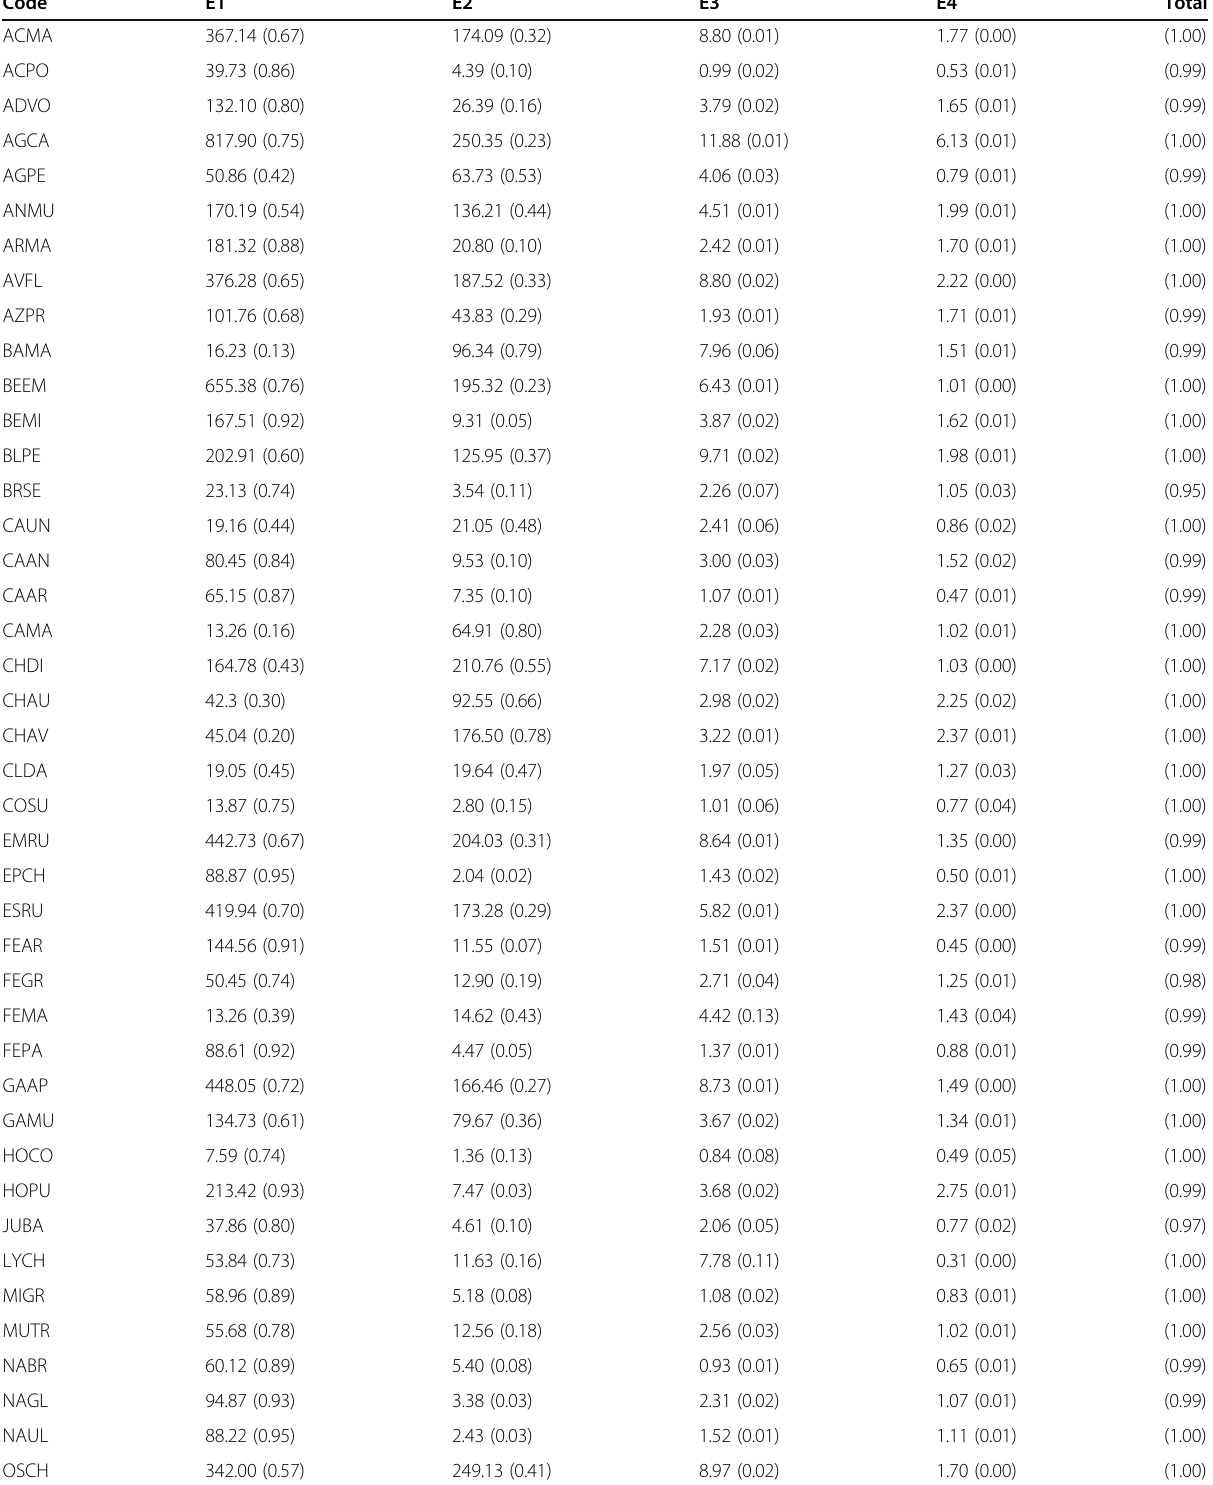
Table 6 Outputs for each potential habitat suitability model of plant species in Santa Cruz Province. Eigenvalues and percentage of explained information corresponded to the first four